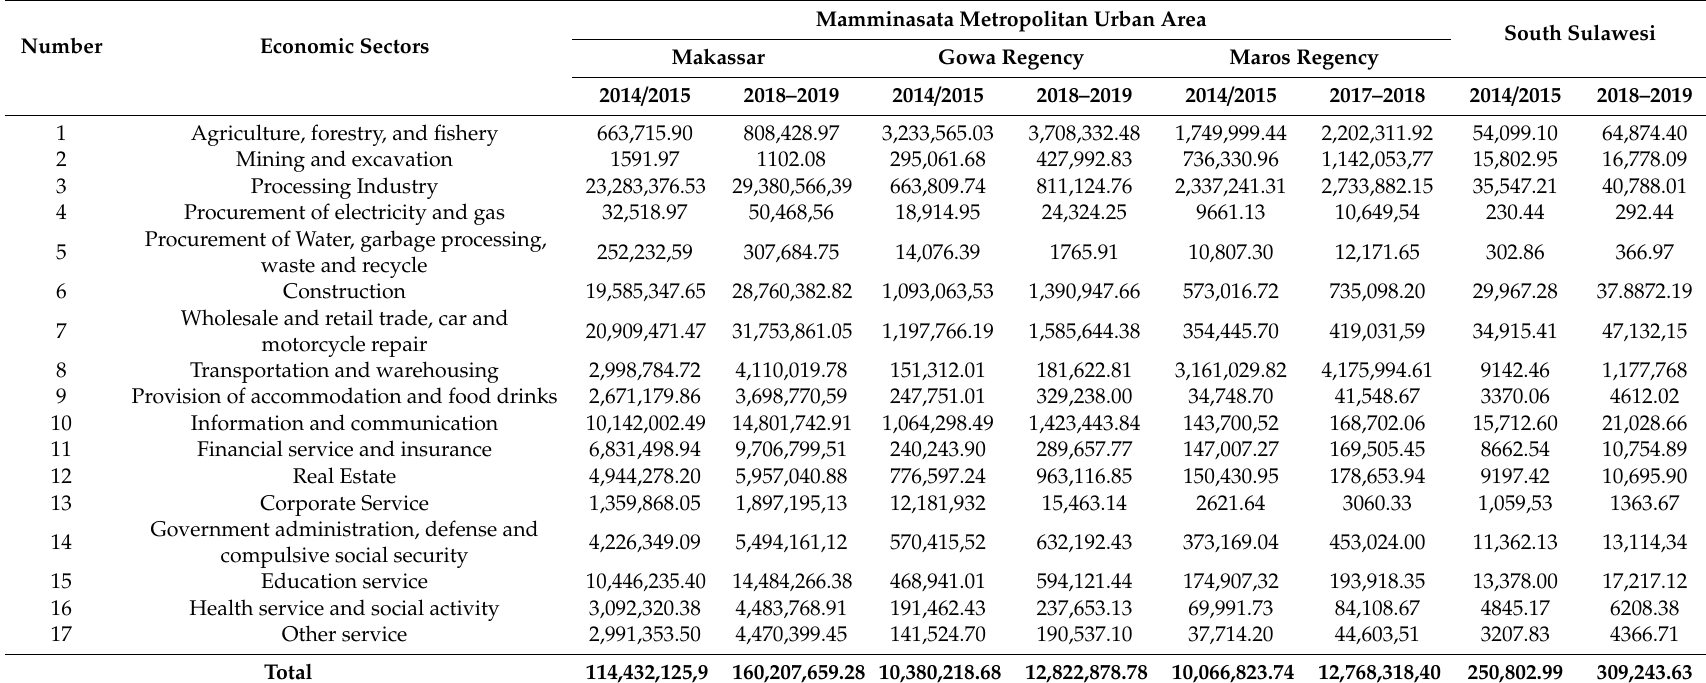
Table A1. Economic Growth of the Mamminasata Metropolitan